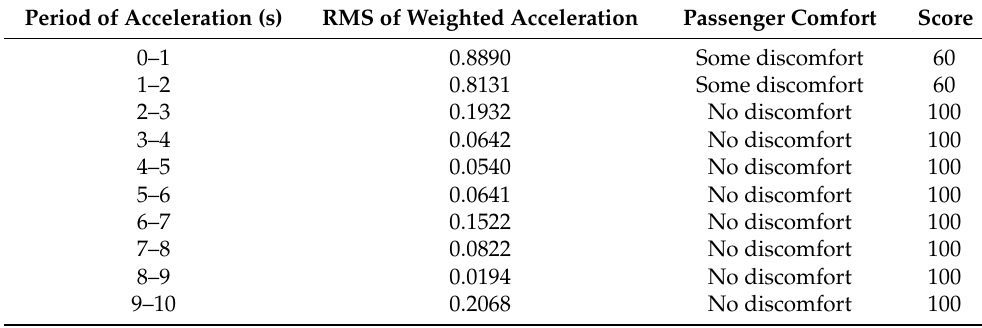
Table 4. Calculation results of RMS of weighted acceleration when straight vehicle gives way. Period of Acceleration (s)